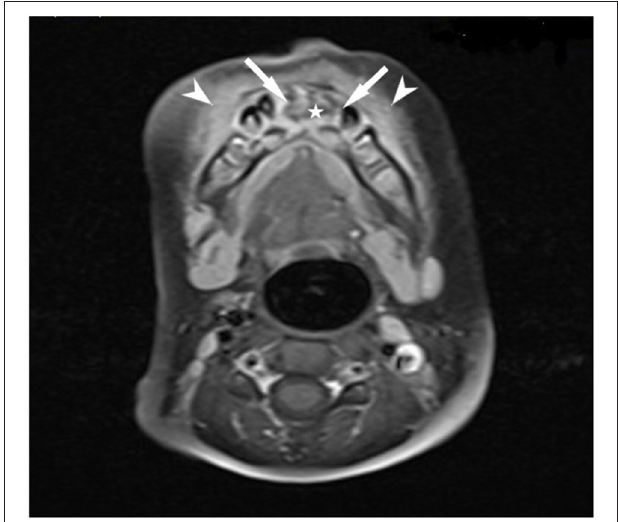
FIGURE 2 | Magnetic resonance imaging of the girl’s mandible (T1 TSE fat sat contrast medium sequence) showed areas of bone necrosis (star) with peripheral reactive bone contrast enhancement (arrows) and enhancement of the soft tissue edema (arrowheads).